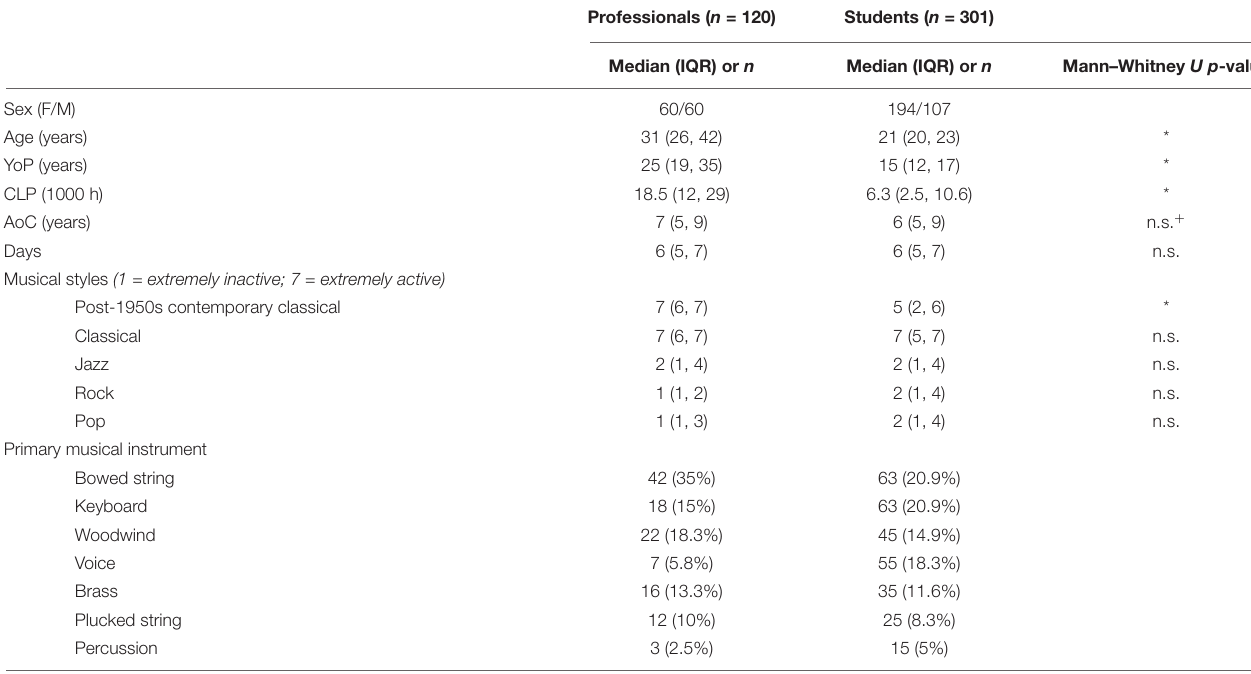
TABLE 1 | Descriptive overview of participants’ demographic and musical experience data.